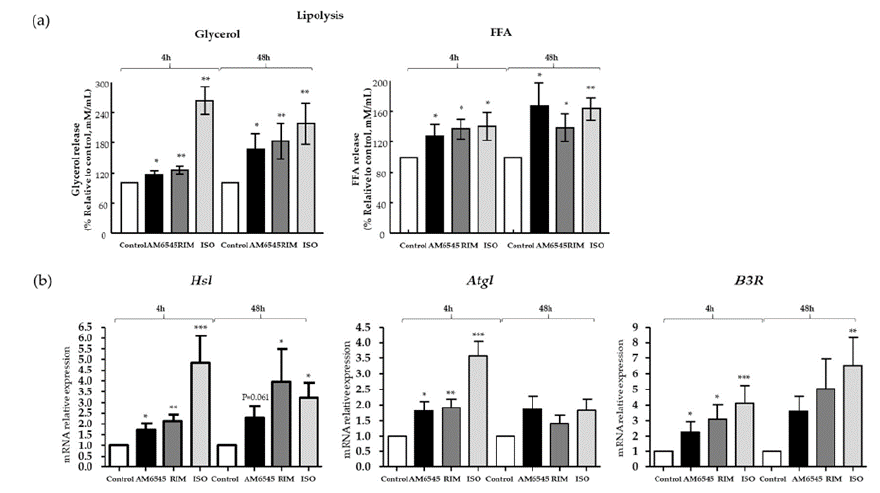
Figure 3. Peripheral cannabinoid receptor 1 (CB1R) antagonist increased lipolysis. 3T3-L1 adipocytes were treated with AM6545, rimonabant (RIM), and isoproterenol (ISO) for 4 and 48 h. ( a ) AM6545